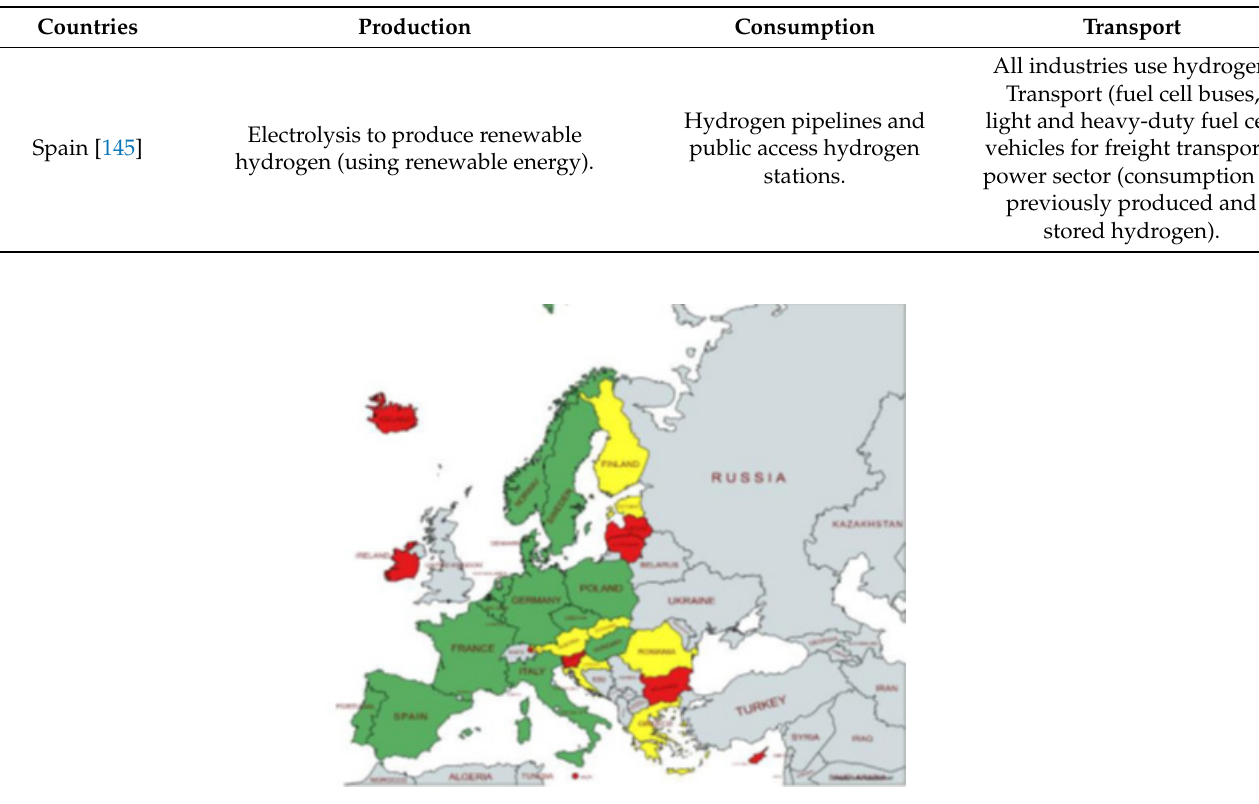
Figure 9. National strategies for hydrogen in Europe (red = do not have a national green hydrogen strategy, green = have a national hydrogen strategy, drafting or in the process of approving a national hydrogen strategy, yellow = in the process of approving or launching a strategy). Table 7. Questions/comments of the Irish Government consultation addressed by this paper Table 6. Comparison of low-carbon hydrogen strategies of EU countries.